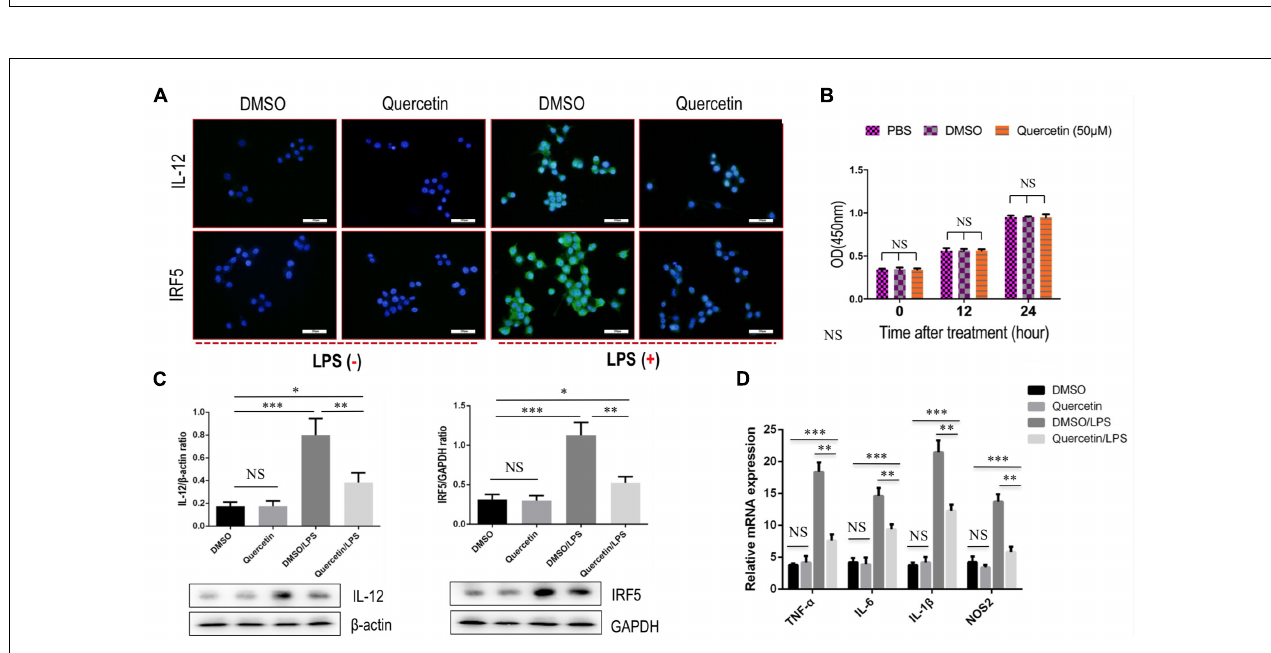
FIGURE 7 | Quercetin treatment suppressed M1 polarization of macrophages in vitro. (A) Representative fluorescence microscopic images of RAW macrophages with anti-IL12 and anti-IRF5 whole-mount staining. Undifferentiated RAW macrophages conditioned medium, and using LPS (100 ng/mL) to induce M1 differentiation. Quercetin- (50 µ M) or DMSO-treated M1-differentiated macrophages conditioned medium. Bars represent mean ± SD of at least three independent experiments. Scale bar = 200 µ m. (B) Effect of quercetin (50 µ M) on the cell viability of macrophages. Cell viability was then determined by the CCK-8 assay as described in the “Materials and Methods” section. (C) Western blotting analysis of M1-markers IL12 and IRF5 protein expression in macrophages RAW 264.7 cells, with results normalized relative to the expression of β -actin or GAPDH ( n = 3). (D) Quantification gene expression analysis of M1-specific markers TNF- α , IL-1 β , IL-6, and NOS2. The mRNA levels were normalized to GAPDH mRNA levels and presented as fold stimulation (mean ± SD ) versus vehicle-treated control. ∗ P < 0.05; ∗∗ P < 0.01; ∗∗∗ P < 0.001; “NS” indicates not significant.